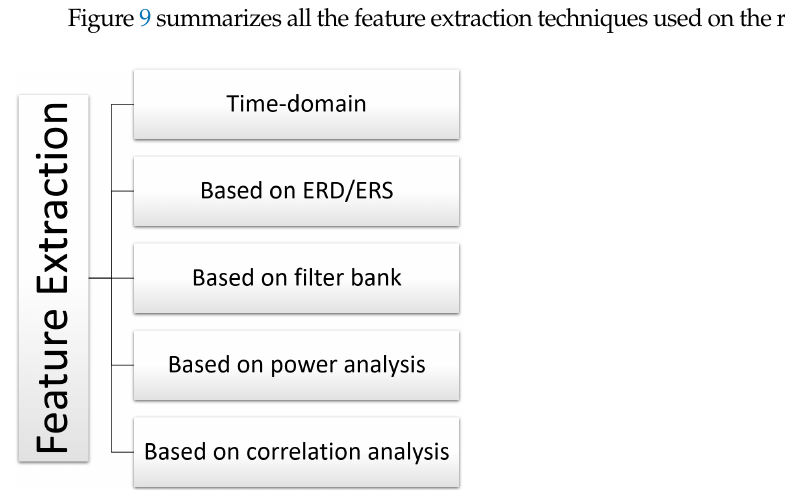
Figure 9. High-level taxonomy and related works for feature extraction. Associated bibliographic references: time-domain [80], based on ERD/ERS [62,77], based on filter bank [63,71], based on power analysis [60,65,66,72,75,76,78,79], and based on correlation analysis